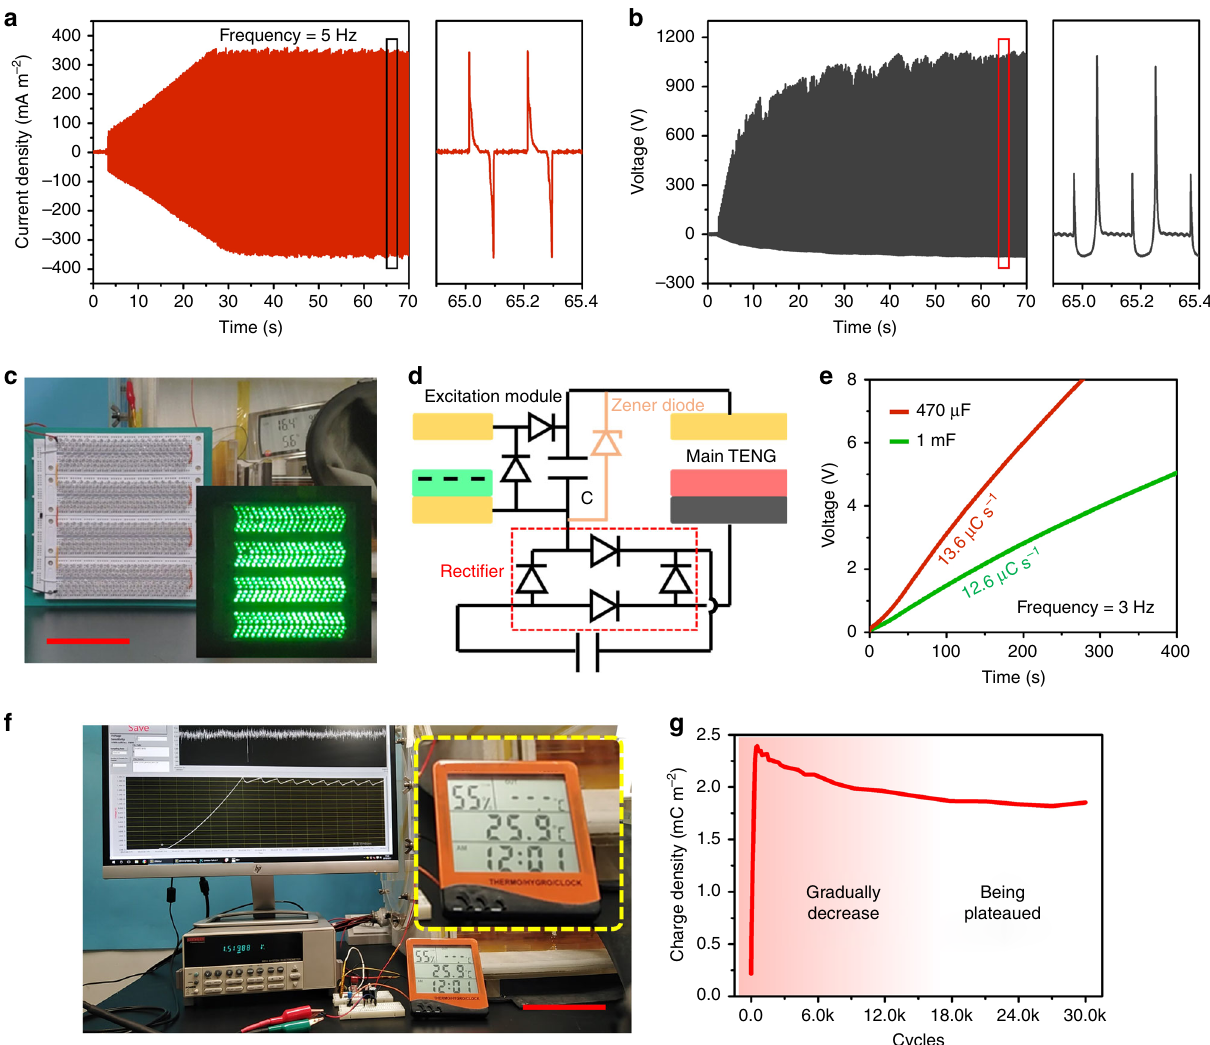
Fig. 4 Demonstrations of high output CE-TENG. a Current density and b voltage output of CE-TENG under 5 Hz operation frequency. c Directly powering hundreds of LEDs by CE-TENG (scale bar: 10 cm). d Electric scheme of CE-TENG for charging capacitor. e Charging curve of 1 mF and 470 μ F capacitor using CE-TENG (frequency: 3 Hz). f CE-TENG for powering thermometer under 5 Hz operation frequency (scale bar: 10 cm). g Long-term stability test of